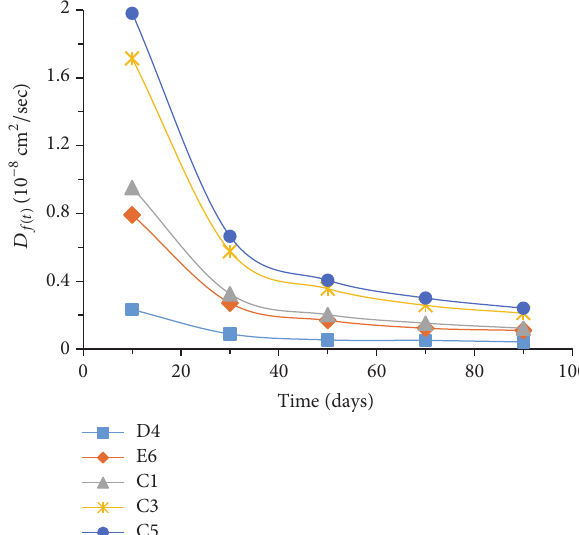
Figure 4: Effect of time on total chloride diffusion coefficient [26].